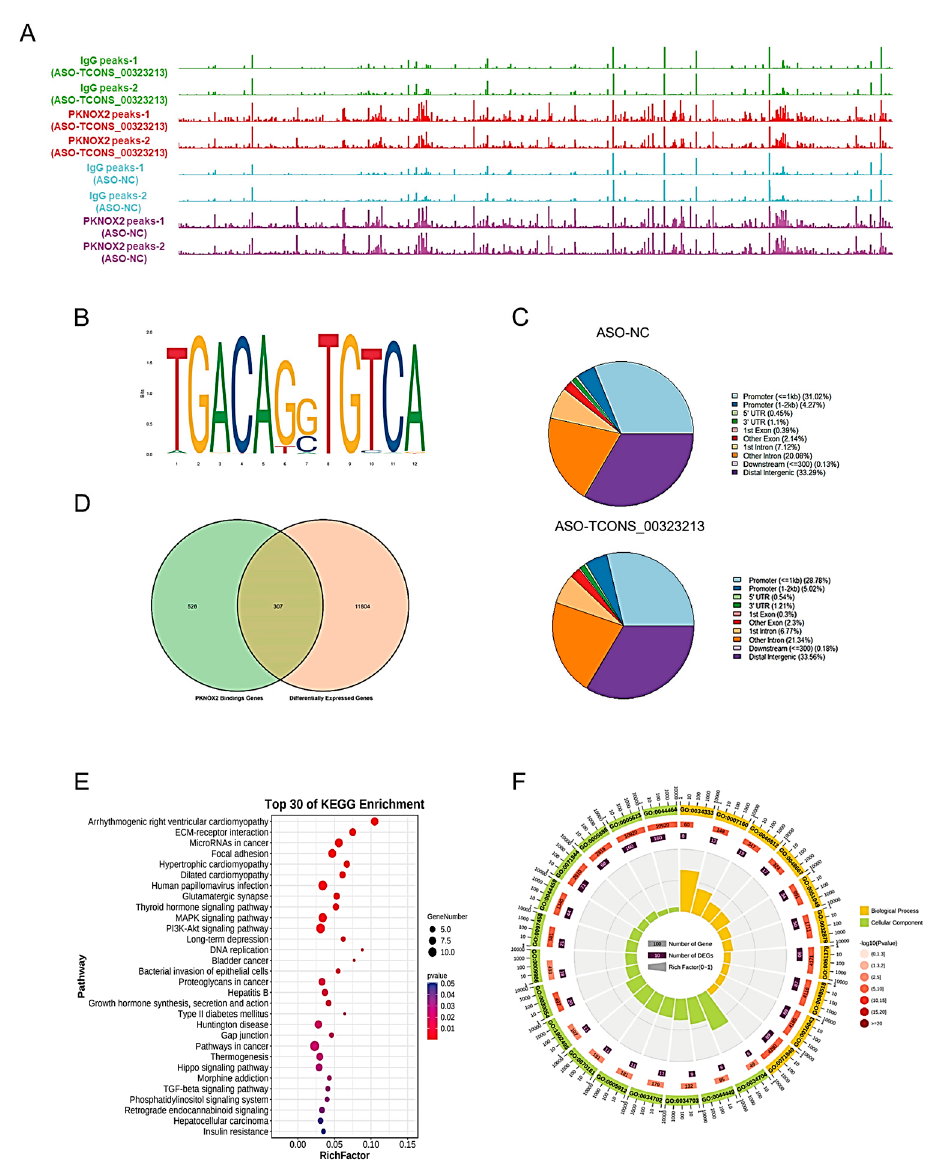
Figure 5. CUT and Tag Analysis of PKNOX2. ( A ) PKNOX2 enrichment analysis. ( B ) PKNOX2 significant enrichment motif sequence. ( C ). Distribution of PKNOX2-enriched regions on the genome. ( D ) Venn diagram of PKNOX2-binding genes versus differentially expressed genes in PSCs with TCONS_00323213 knockdown. ( E ). KEGG pathway enrichment analysis of the 307 genes in panel ( D ). ( F ). GO enrichment analysis of the 307 genes in panel ( D ). The RNA-seq experiment had three biological replicates, and the CUT and Tag experiment had two biological replicates.